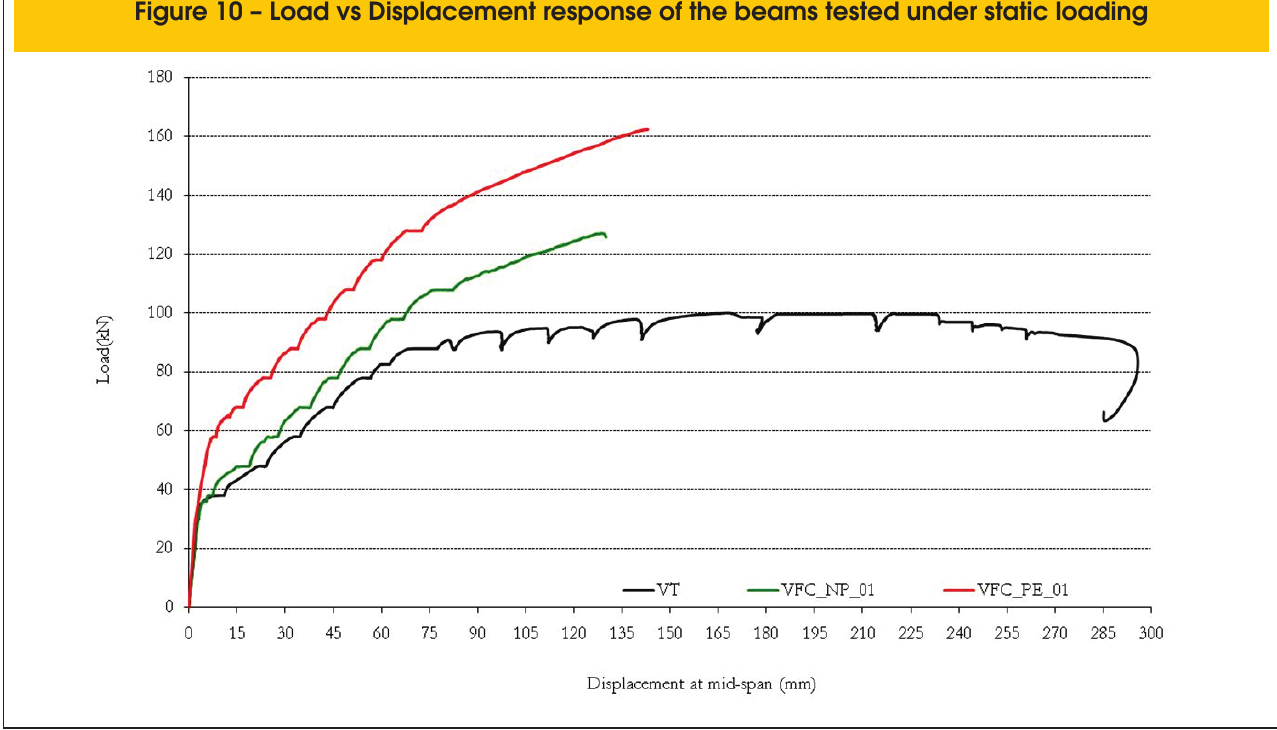
Figure 10 – Load vs Displacement response of the beams tested under static